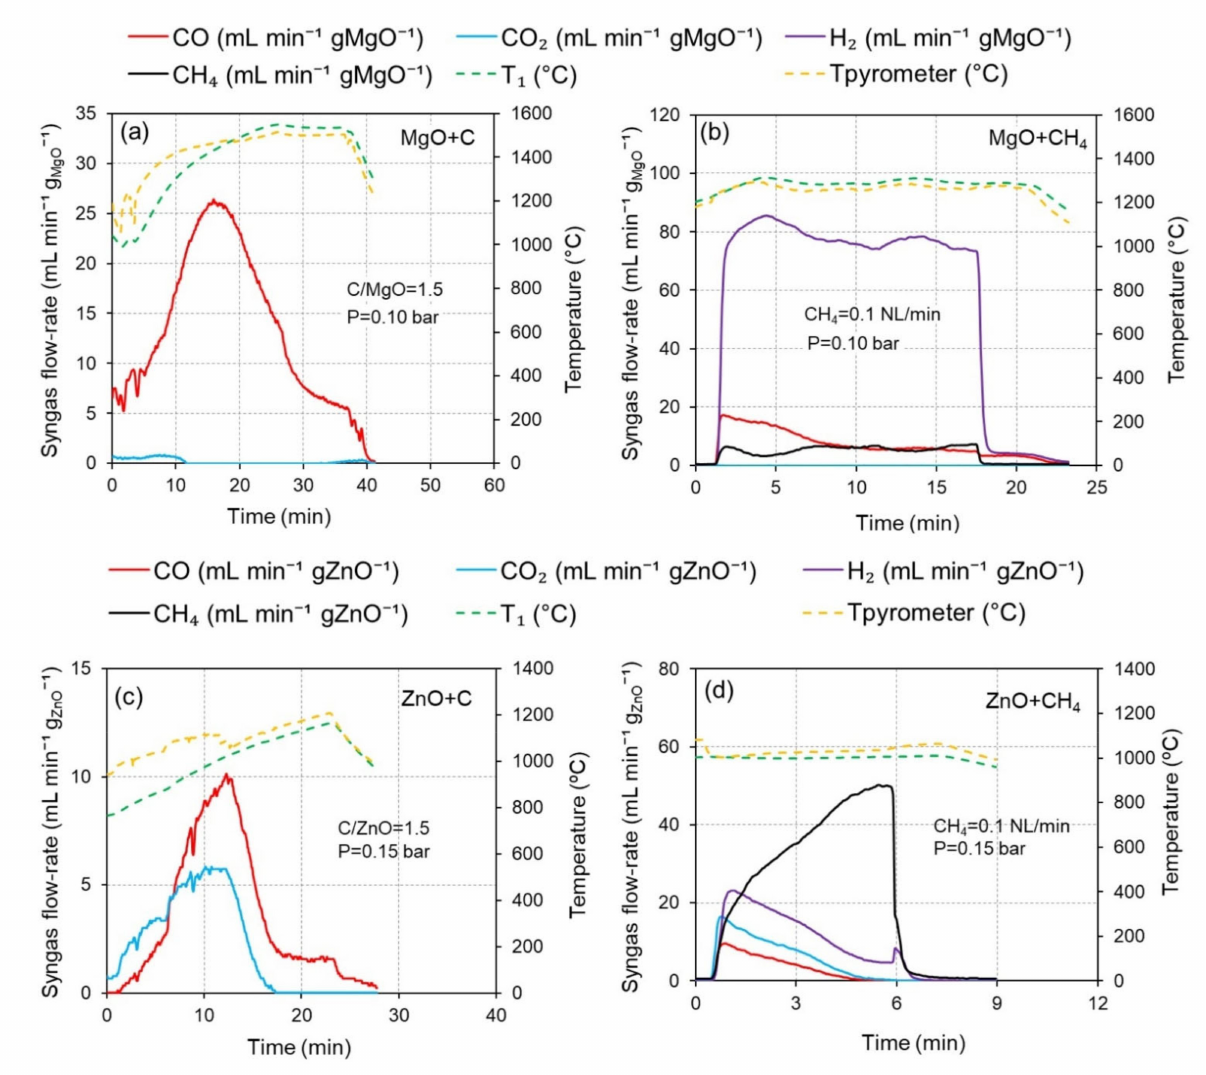
Figure 7. Syngas production rate along with reactor temperatures for the ( a ) CTR of MgO, ( b ) MTR of MgO, ( c ) CTR of ZnO, and ( d ) MTR of ZnO, under low pressure operations (0.10–0.15